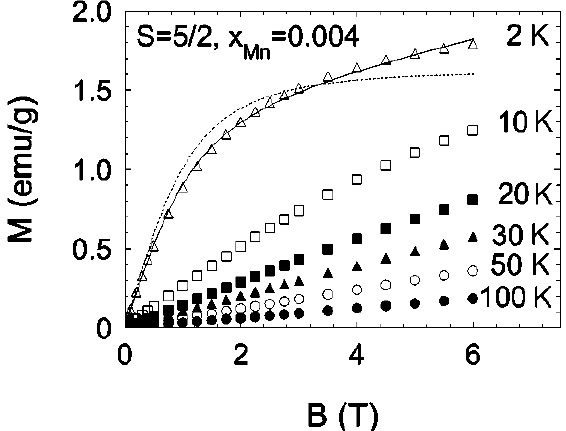
Figure 1. Magnetization of a Ga 1 − x Mn x N layer with 0.4% Mn acquired at different temperatures. The dashed line fit to the data at 2 K is for pure Brillouin paramagnetism and the solid line is the Brillouin and an additional antiferromagnetic component attributed to the Mn 3 N 2 nanoclusters. Reproduced with permission from Reference